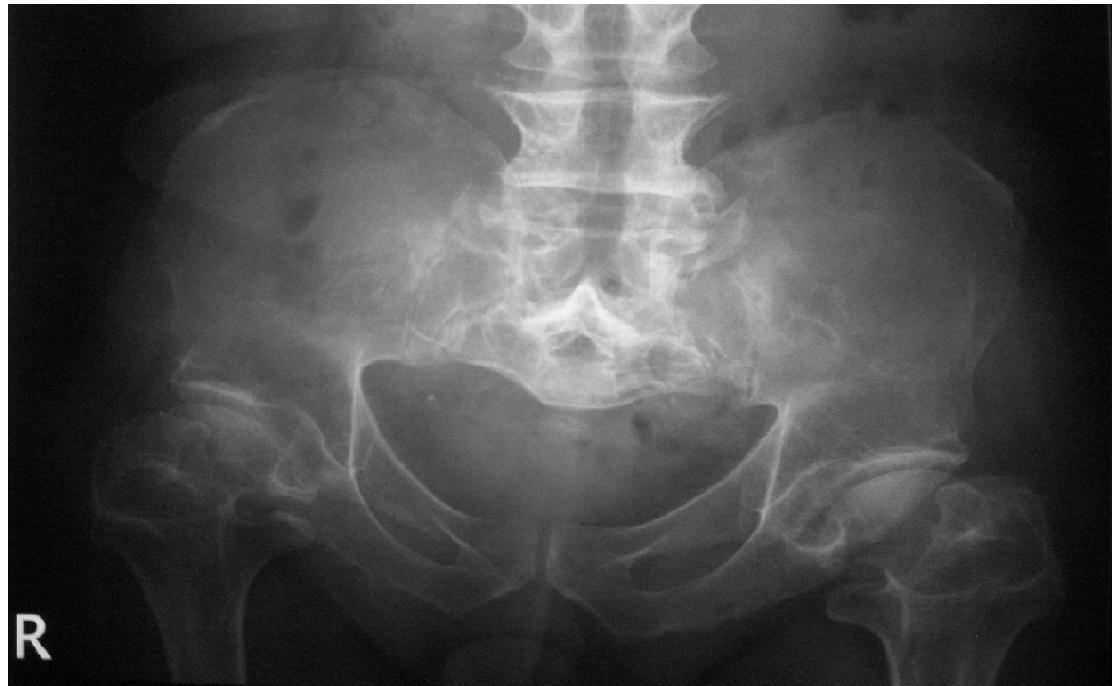
FIGURE 1. Plain abdominal radiograph in the ACH patient demonstrating an extremely narrow